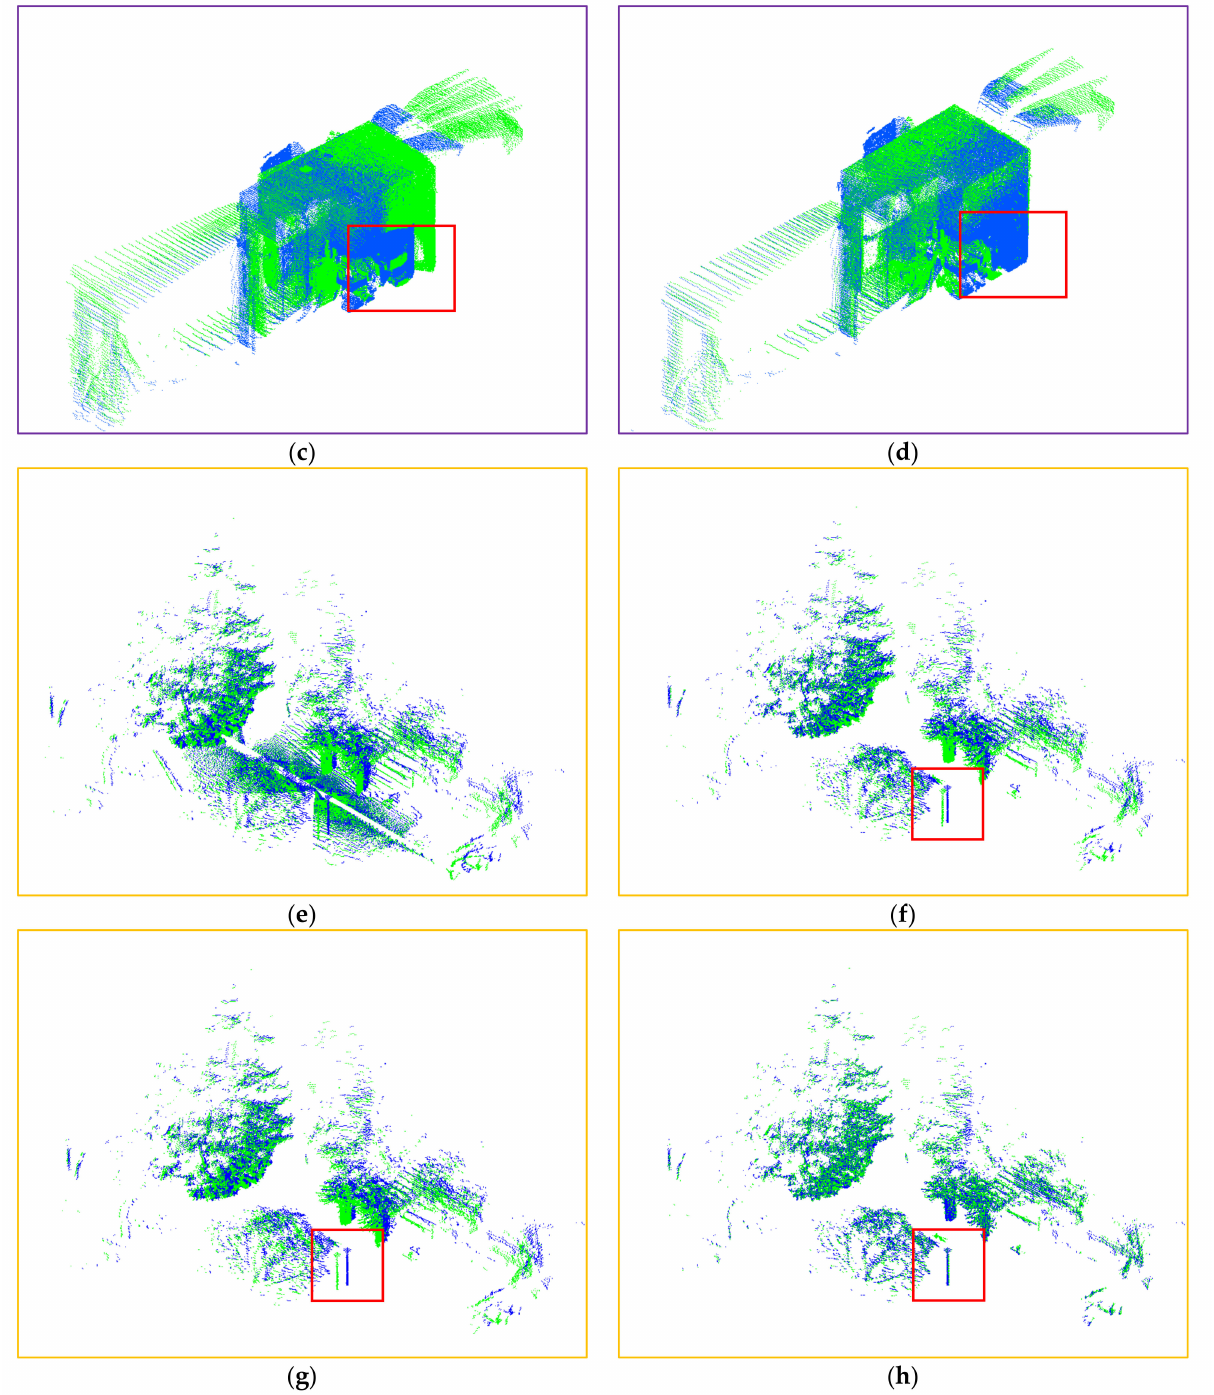
Figure 7. The registration results of scan #1 to scan #0 in Dataset III and Dataset IV; ( a , e ) are the original two scans of Dataset III and Dataset IV; ( b , f ) are obtained by Method III; ( c , g ) are obtained by Method IV; ( d , h ) are obtained by our method ( k =